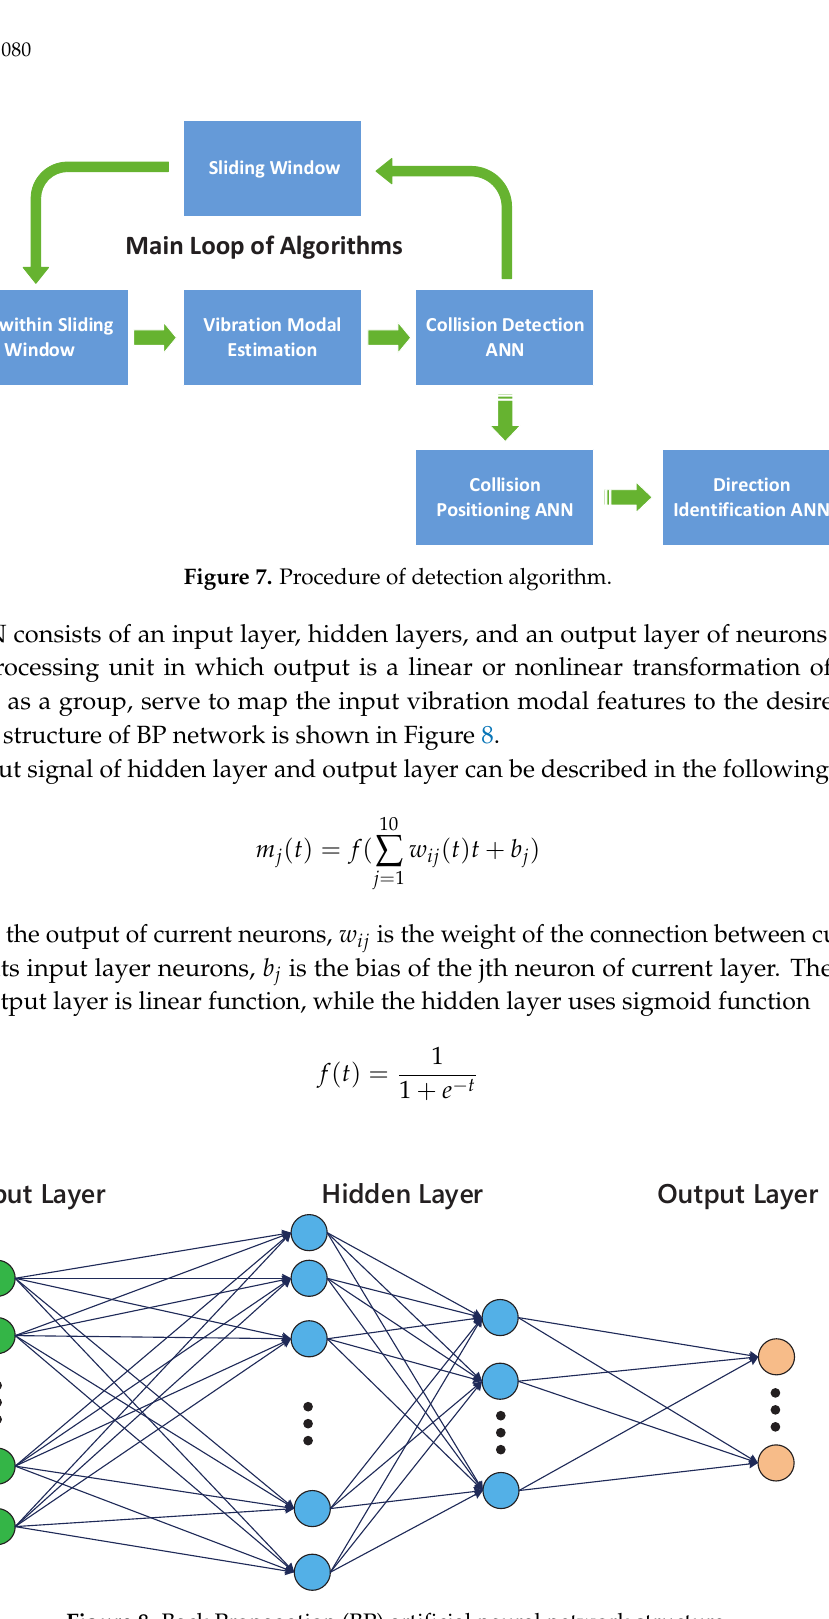
Figure 8. Back Propagation (BP) artificial neural network